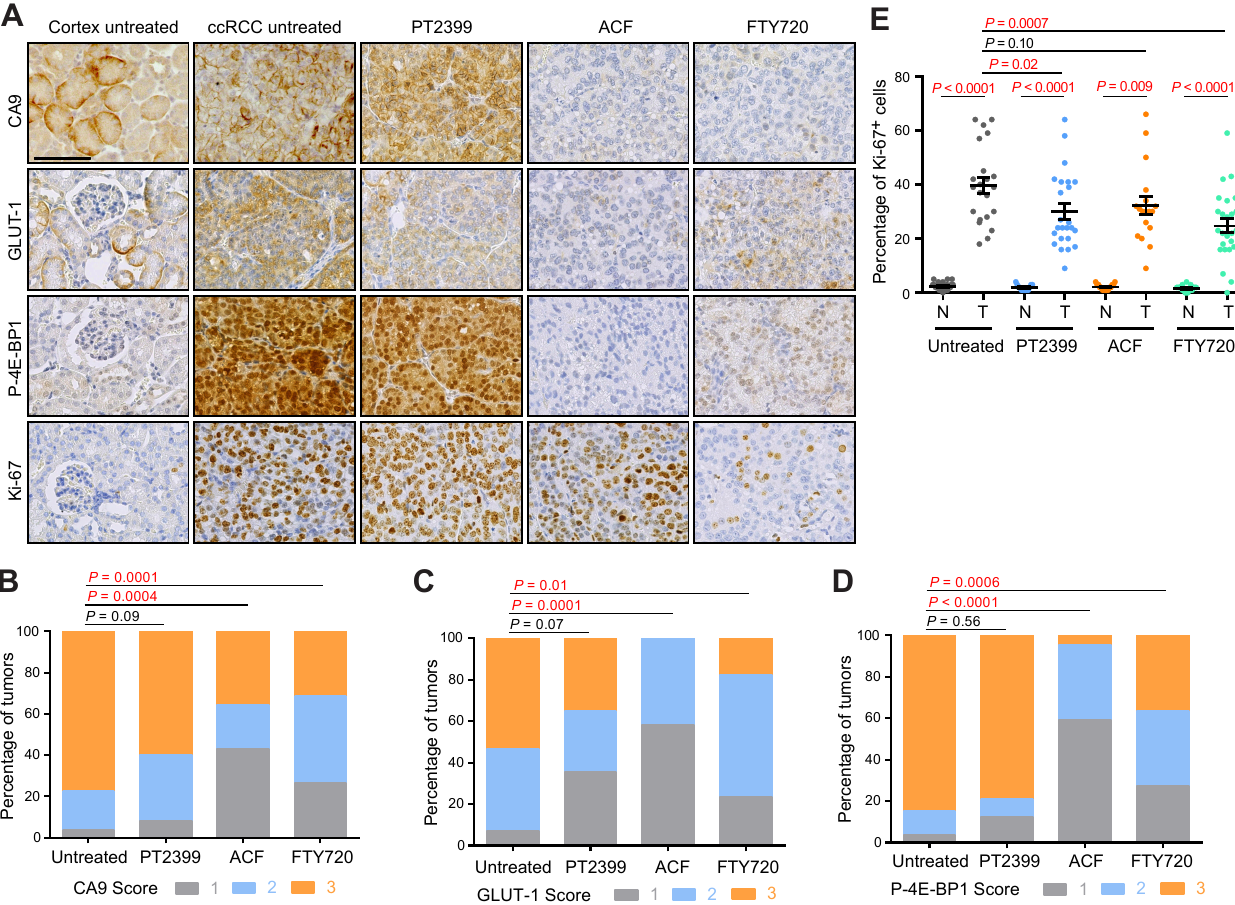
treated cohorts, respectively. p -values for pairwise comparisons were calculated by two-sided unpaired T-test with Welch’s correction. ( C ) Examples of histological appearances of untreated and treated tumors. Scale bar = 100 µ m. ( D , E ) Scoring of clear cell phenotype ( D ) and nuclear grade ( E ) in the indicated numbers of Vhl/Trp53/Rb1 (VpR) tumors treated with the indicated drugs. For comparison, previously published [15] scores of Vhl/Trp53/Rb1/Hif1a (VpRH1) and Vhl/Trp53/Rb1/Hif2a (VpRH2) mutant ccRCC tumors are included. p -values were calculated using the two-sided Mann–Whitney U test without adjustments for multiple comparisons.